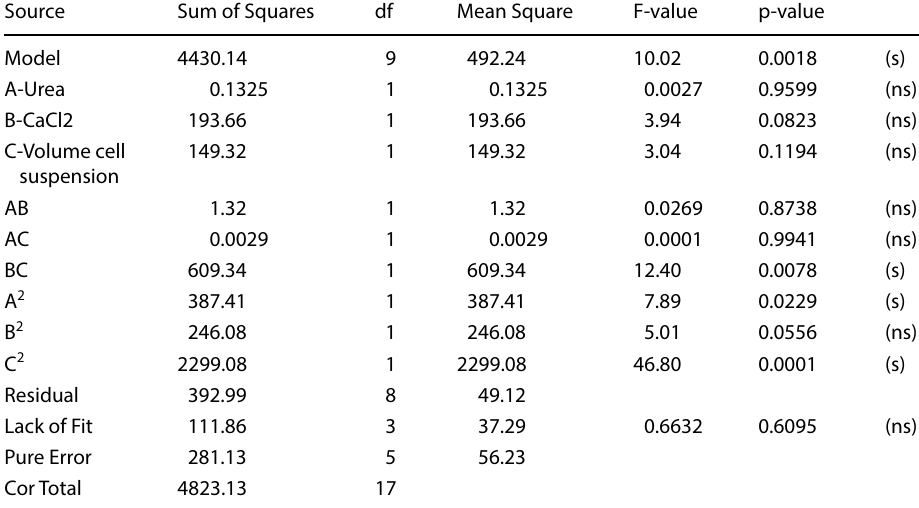
Table 4 Design analysis for the predictive equation by the Design expert